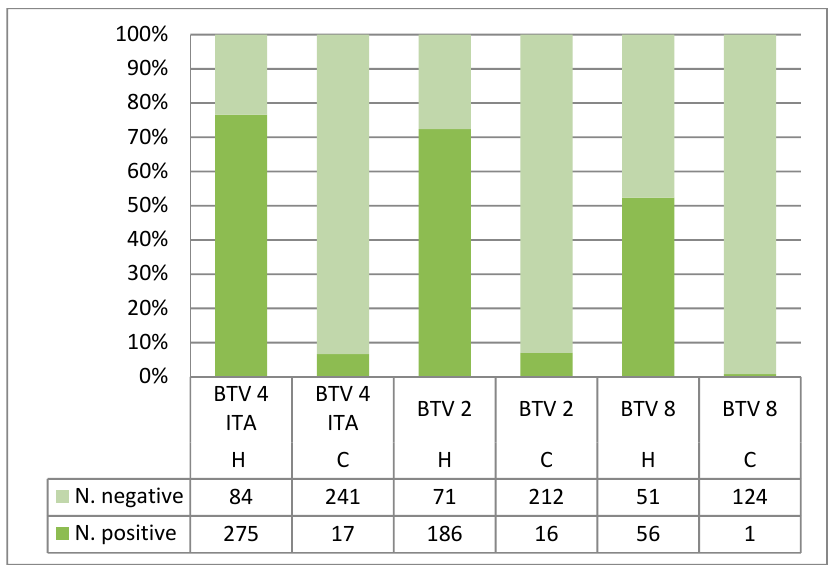
Figure 2. Recovery rate of bluetongue virus strains from Culicoides imicola (Sardinia population) fed through different methods: Hemotek device (H), cotton wool pledgets (C). Table 7. Recovery rate (serogroup-specific RT-PCR) and relative 95% confidence interval of Culicoides obsoletus and C. scoticus fed on BTV-infected blood at 0 and 10 days post-infection.